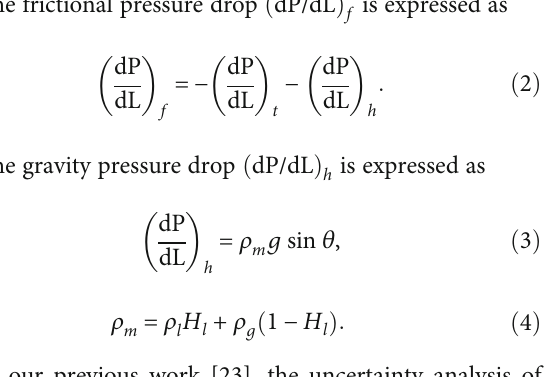
Figure 2: Pictures of churn fl ow in the air-oil experiment ( v =0.15 m/s, v sg